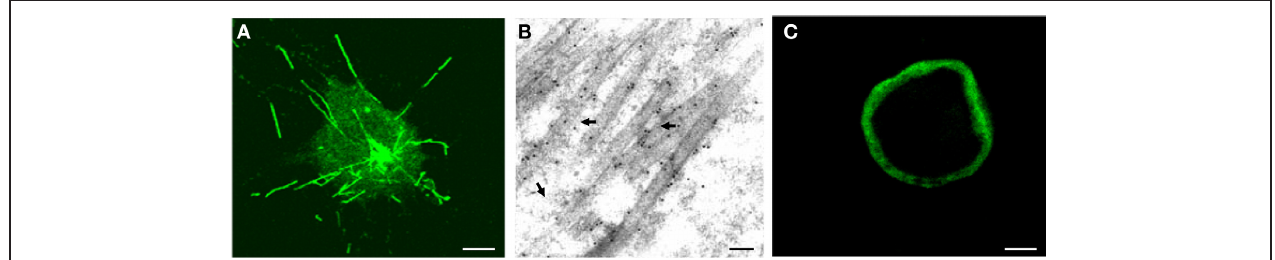
FIGURE 3 | Subcellular localization of Pns11 in recombinant baculovirus-infected Sf9 cells at 72hpi. (A) Immunofluorescence staining of Pns11 showing tubule-like structures within the cytoplasm or protruding from the cell surface. Sf9 cells were immunostained with Pns11-FITC. Bar, 10 µ m. (B) Immunogold labeling of Pns11 in the tubules. Cells were immunostained with